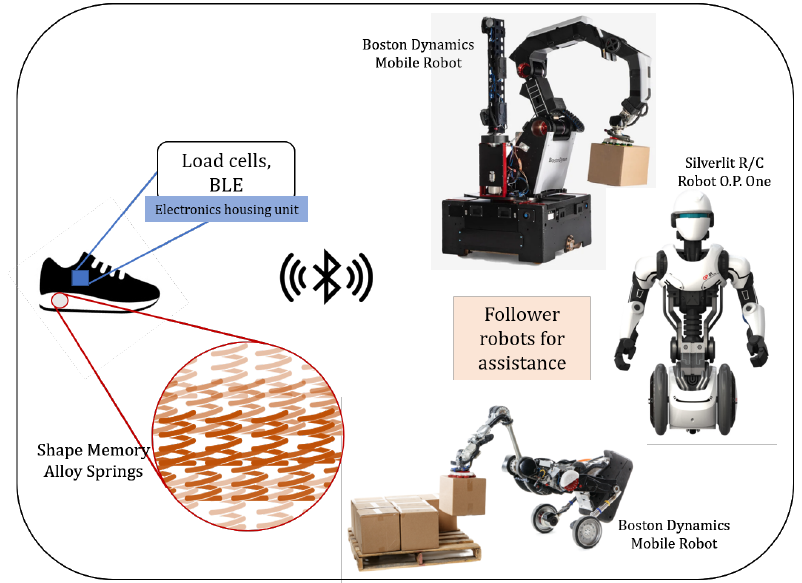
Figure 8. Human-Robot Interaction Use Case: Smart Shoes. Human leaders followed by robots would be associated with significant and better performance in productivity, engagement, role ambiguity, and employee